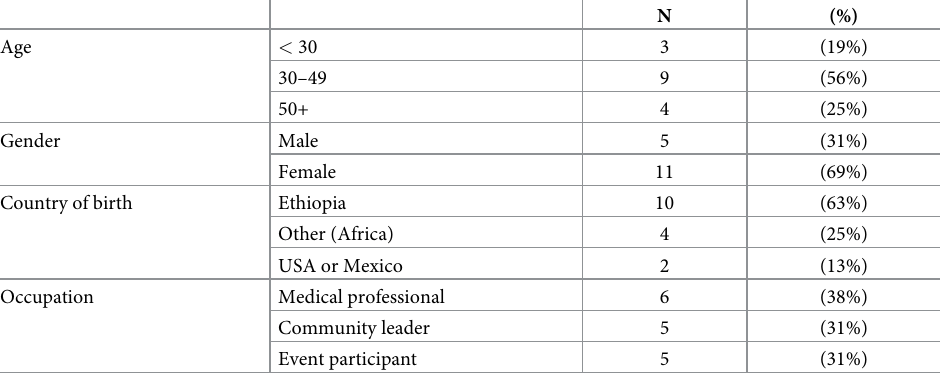
Table 1. Demographics and occupation of 16 key informant interview